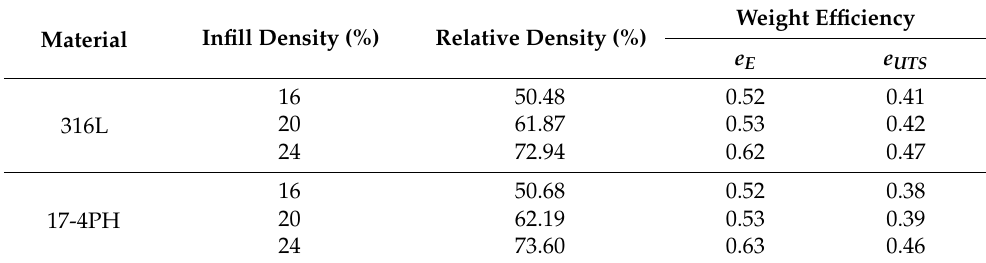
Table 6. Weight efficiency of 316L and 17-4PH